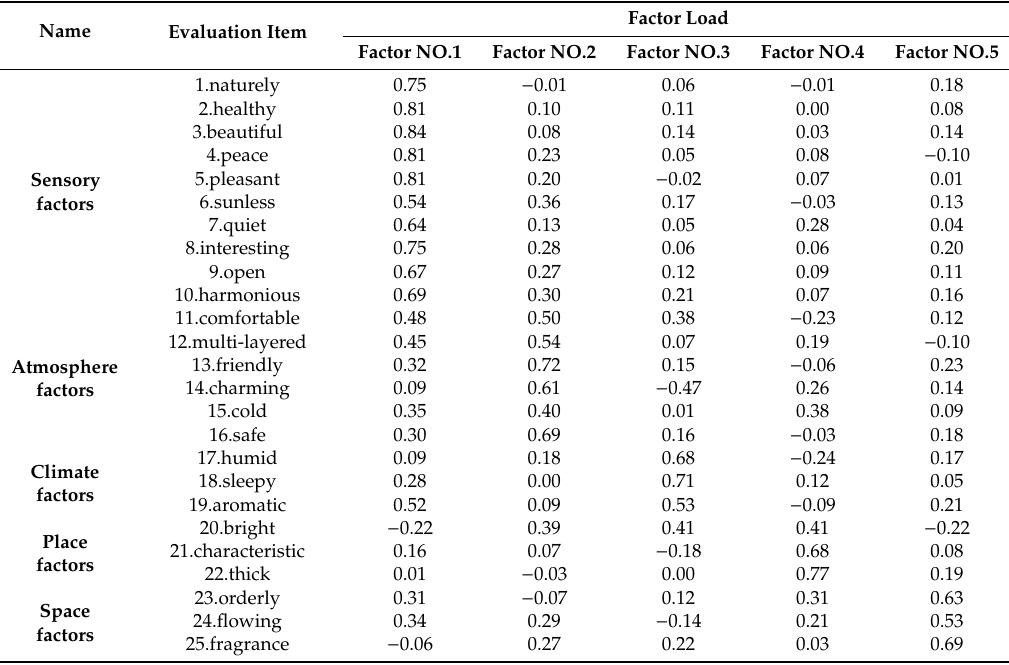
Figure 4. Comparison of environmental characteristics between the bamboo forests and the urban environment. Table3. Resultsofprincipalcomponentanalysis. Datashowtheresultsofprincipalcomponentfactoring based on the results obtained from the SDM questionnaire, data are presented as the means ± SD; n = 348; p <